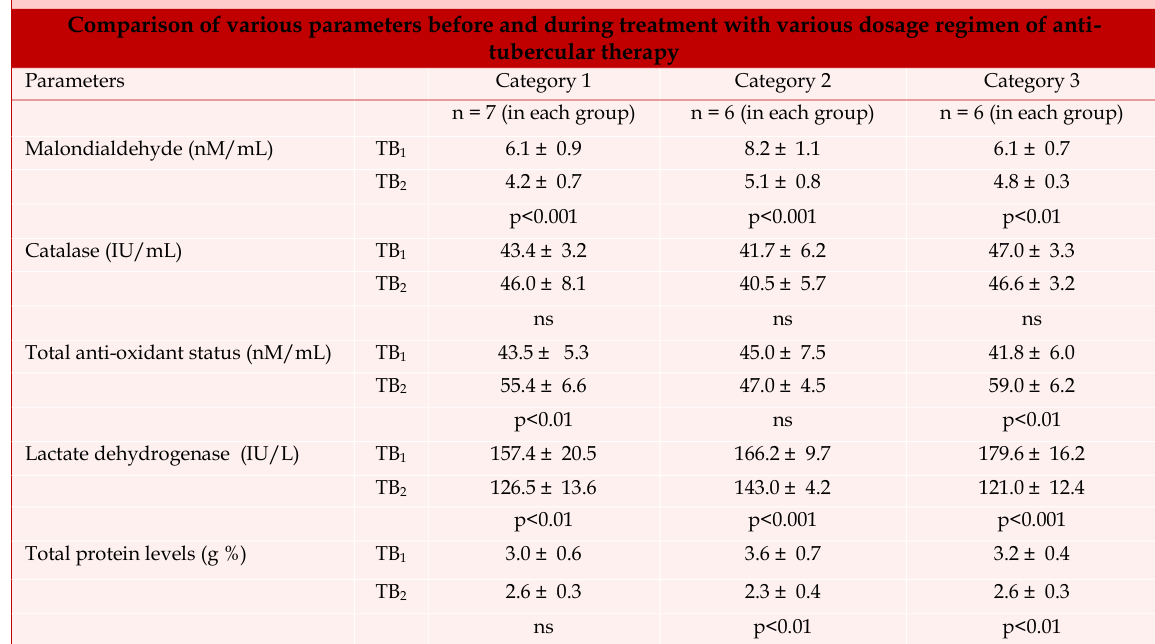
Comparison of various parameters before and during treatment with various dosage regimen of anti- tubercular